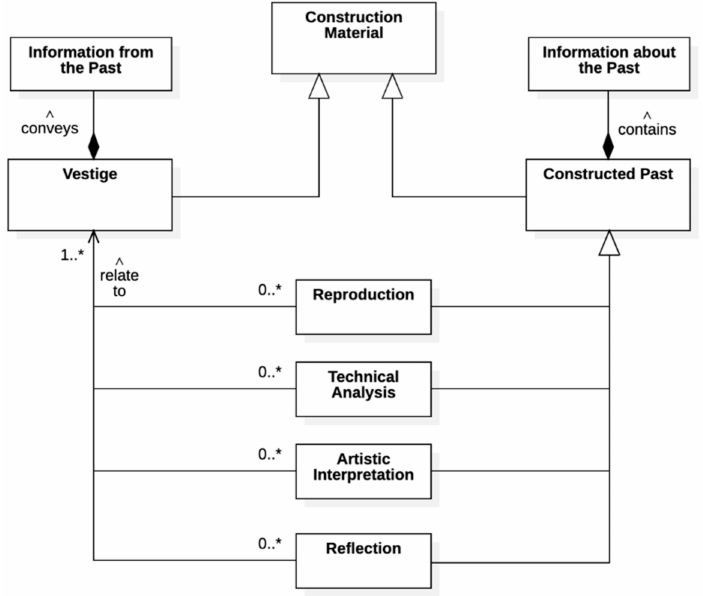
Figure 2. Construction Material. Construction Material conveys information related to a Target Past. Its subclasses, Vestige and Constructed Past, respectively provide information from or about the past. Constructed Past has several subclasses: Reflection, Reproduction, Technical Analysis, and Artistic Interpretation. All relate to one or more Vestiges, as indicated by “1..*” at the arrow pointing to